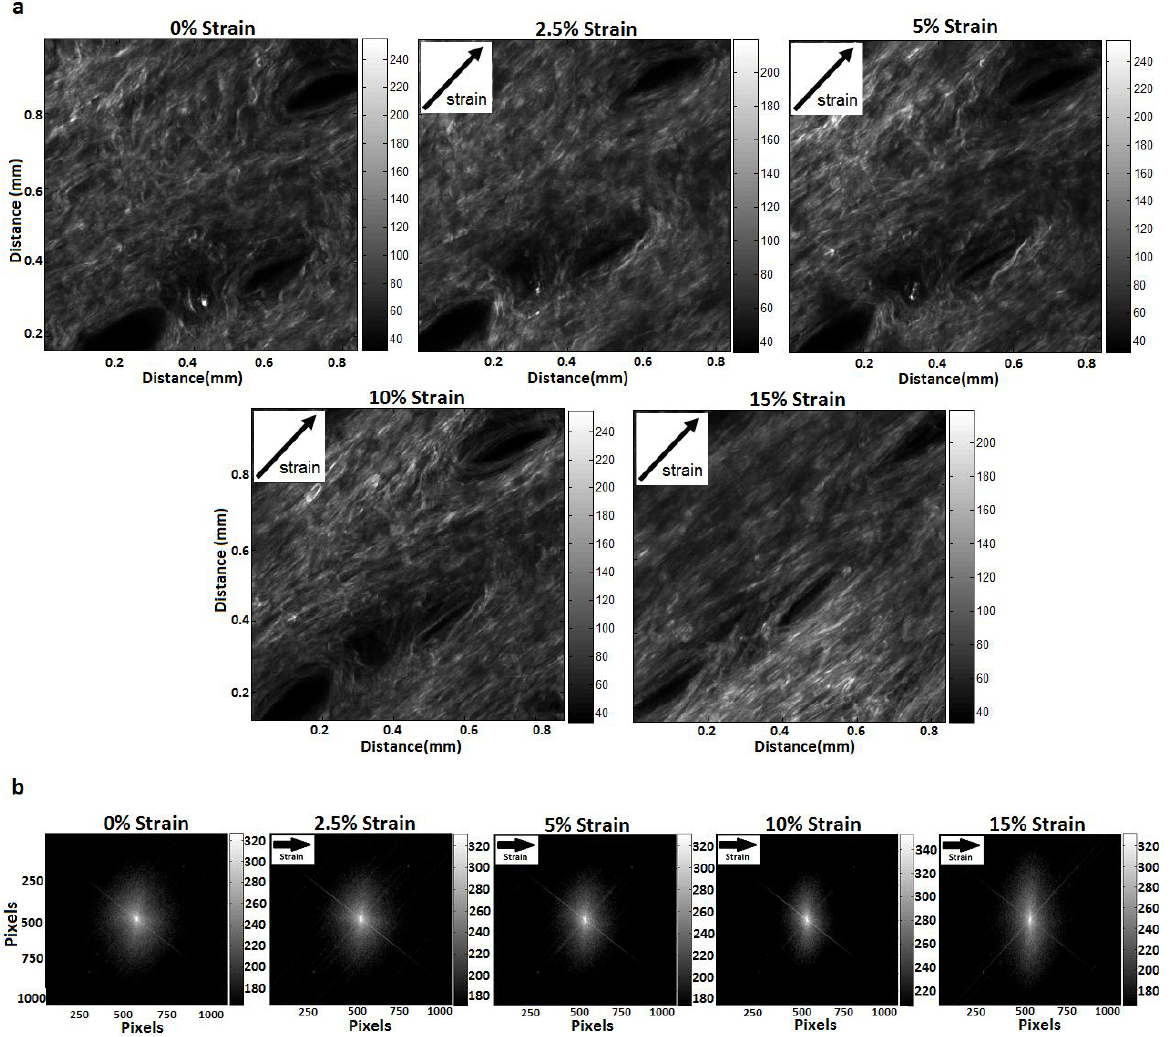
Figure 2. Representative Second Harmonic Generation (SHG) images and the respective fast Fourier transforms (FFT) for a random sample. ( a ) SHG images of skin at different strain magnitudes. Strain was applied at 45° to the x-y scans. Each image is single frame from a 70–100 z-stack images obtained at each strain level. As the strain increases, a greater number of fibrils align in that direction; ( b ) FFT amplitude images reoriented in the direction of applied strain (horizontal direction). Arrows indicate the direction of applied